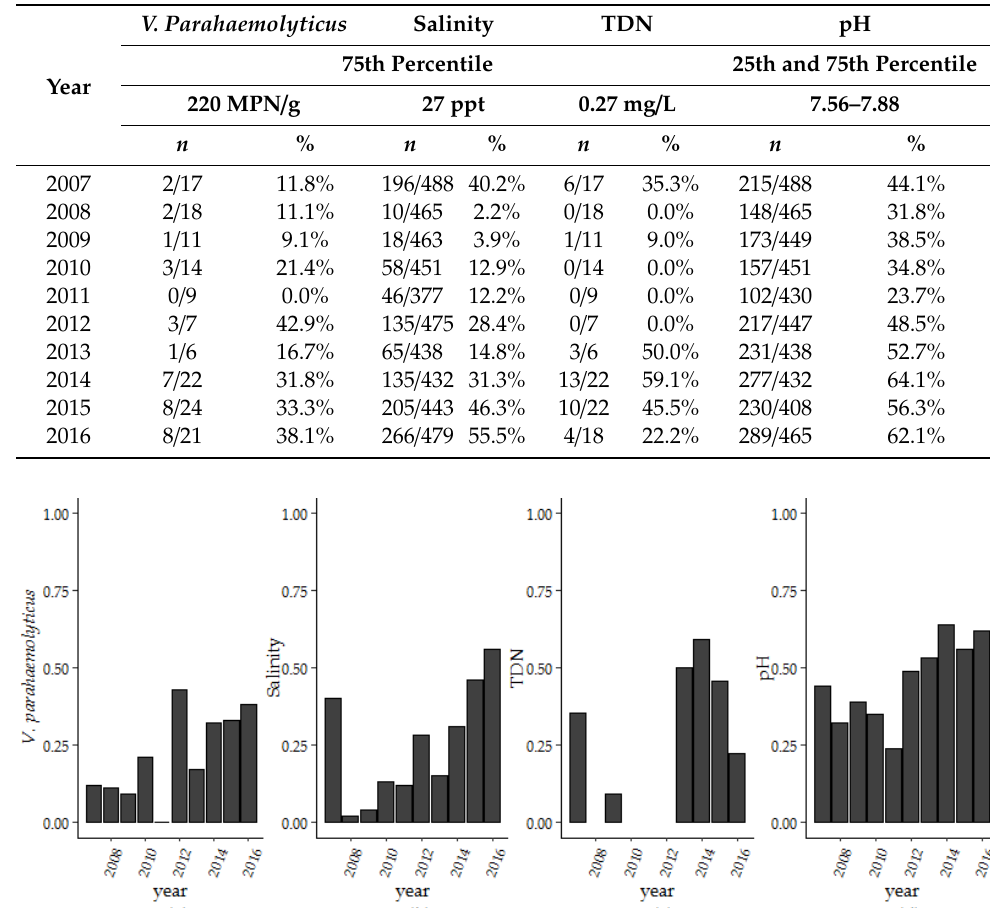
Table 2. Trends of the frequency of days when V. parahaemolyticus concentrations, water temperature and salinity exceeded the 75th percentile of data and pH data were within the 25th to 75th percentile range in GBE during the period 2007 to 2016.